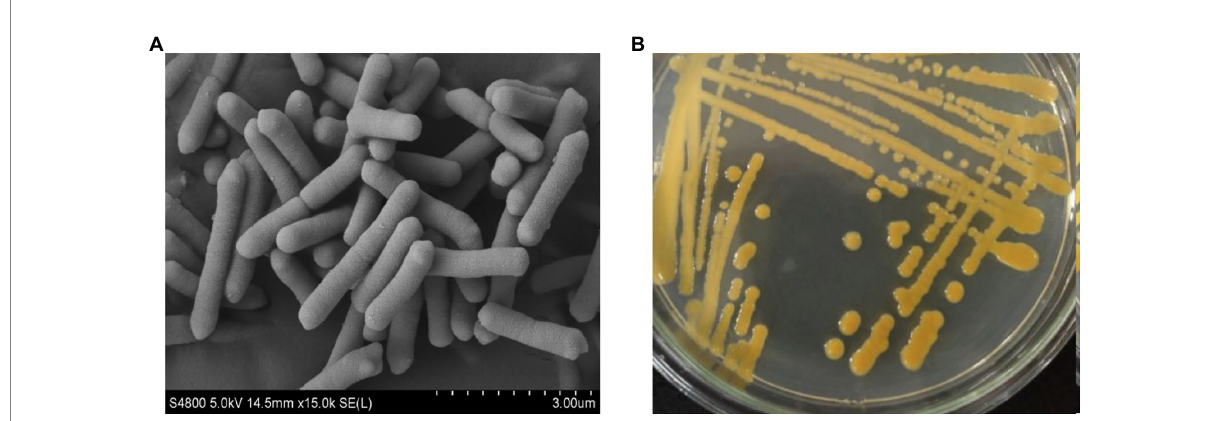
FIGURE 1 Scanning electron micrograph scanned at 15,000 magnification (A) and morphological characterization grown on seed culture medium agar at 30 ° C for 48 h (B) of strain